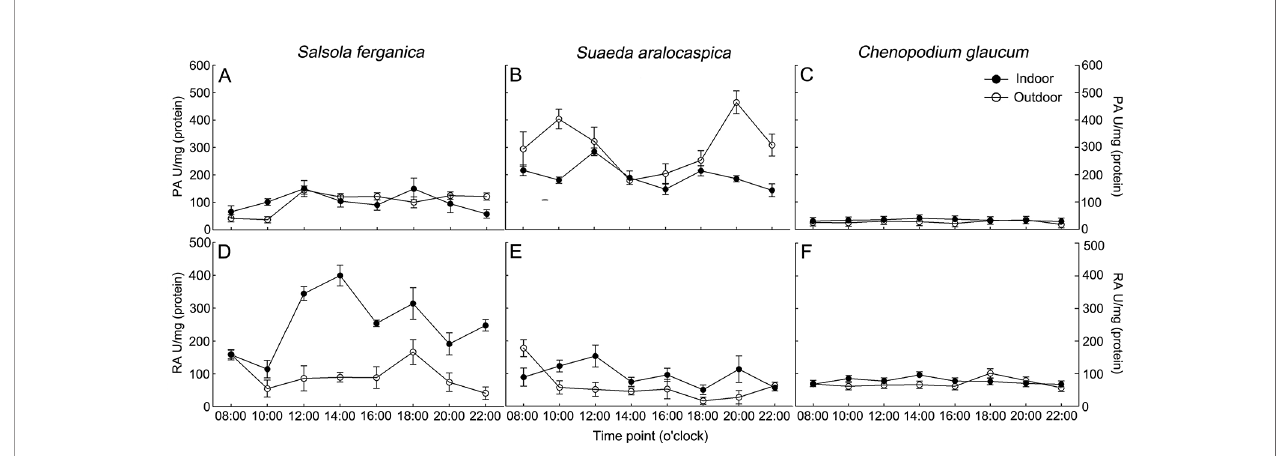
FIGURE 4 | Diurnal changes of PEPC and RUBPC activity in S. ferganica , S. aralocaspica and C. glaucum . (A, D) S. ferganica ; (B, E) S. aralocaspica ; (C, F) C. glaucum ; (A – C) PEPC activity; (D – F) RUBPC activity. Indoor, in greenhouse; Outdoor, out of greenhouse. PA, PEPC activity; RA, RUBPC activity.